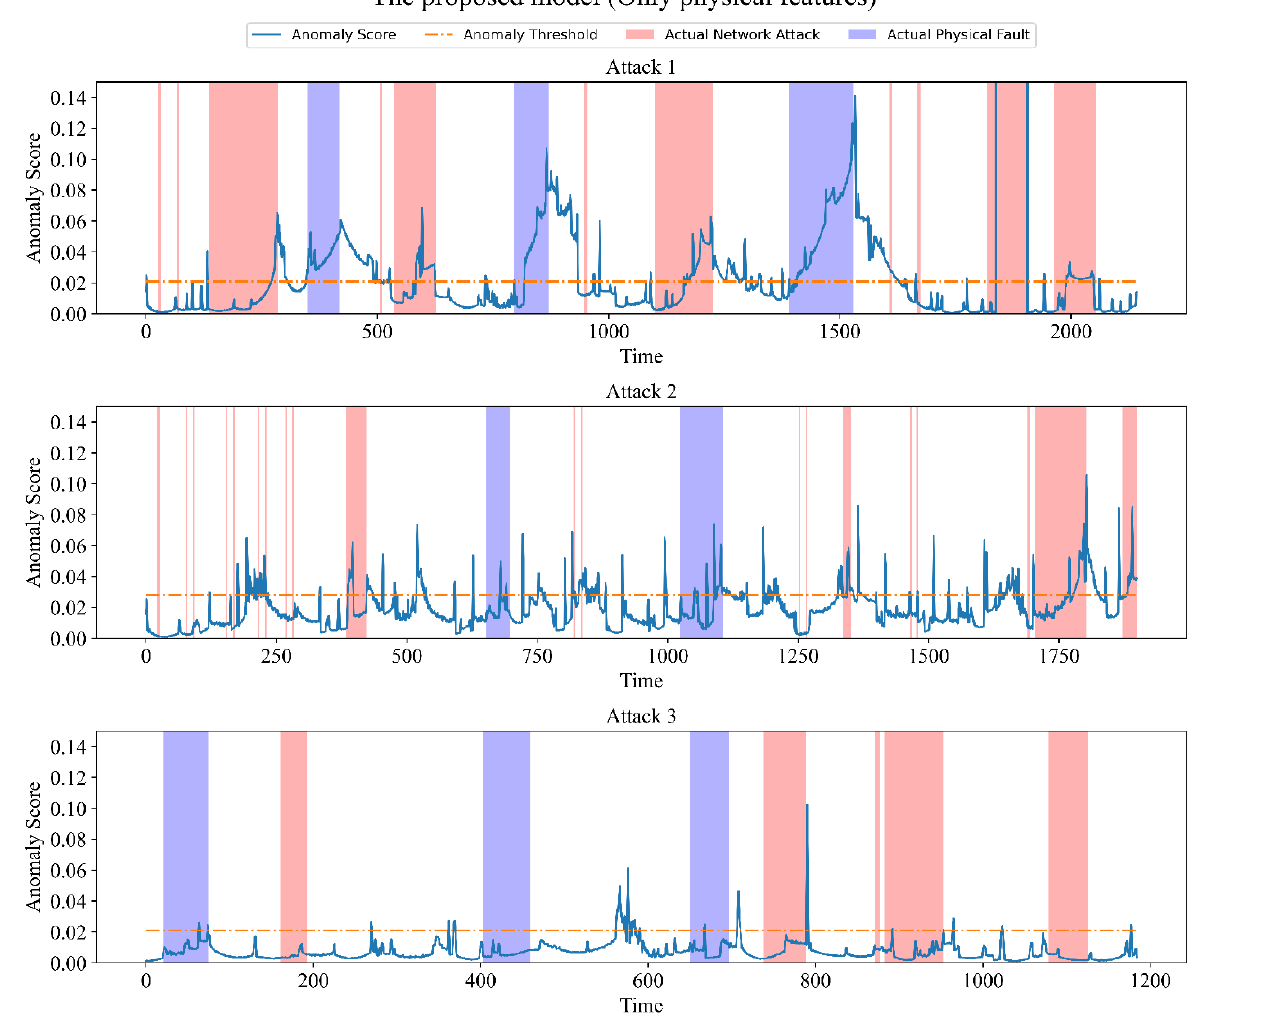
Figure 6. Anomaly scores for the proposed model (using only physical